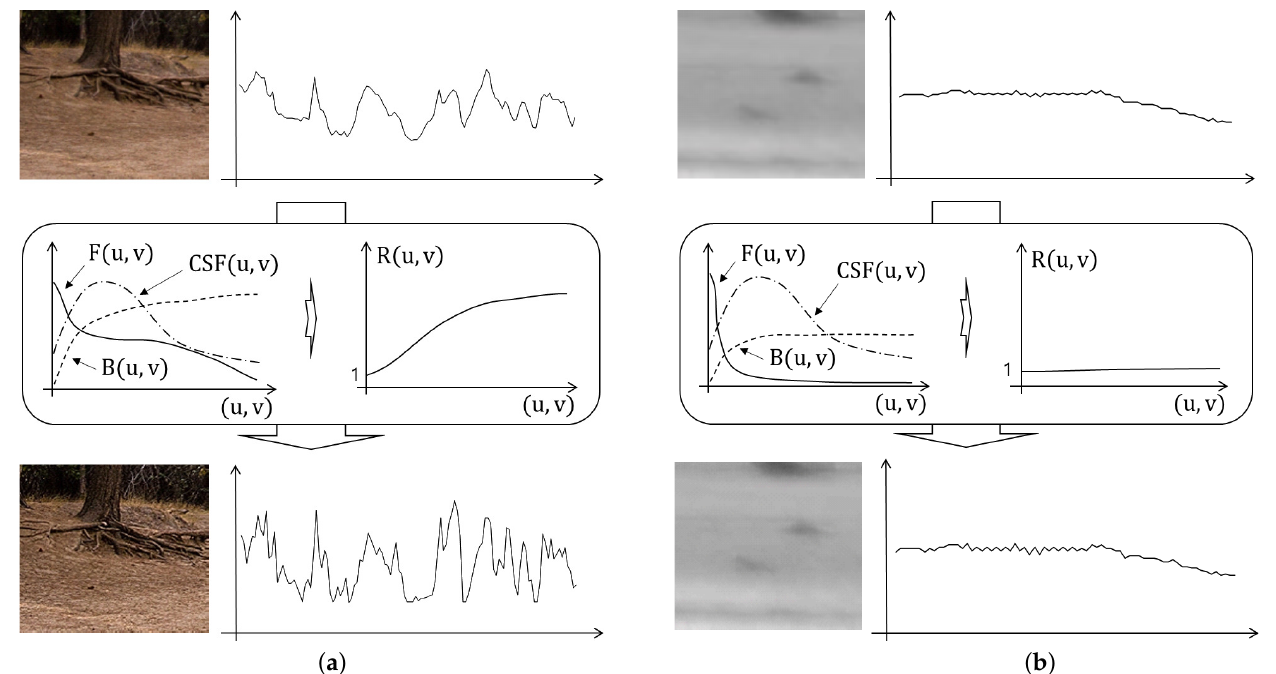
Figure 2. The proposed energy scalar spectrums for texture and plane images and their images enhanced by the proposed method. ( a ) A texture image. ( b ) A plane